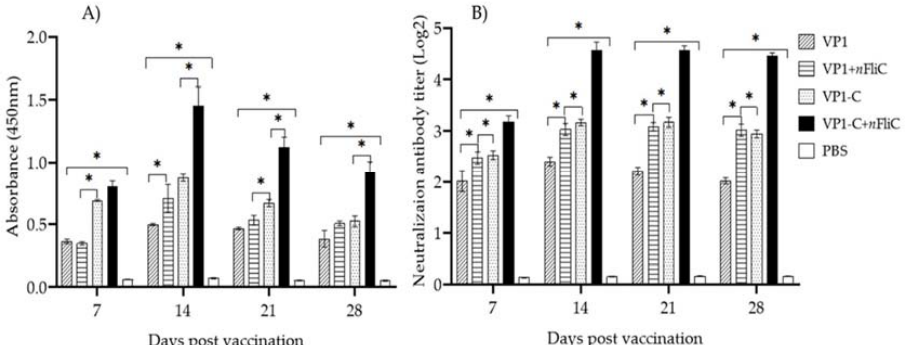
Figure 2. Virus-specific antibody levels of vaccinated ducklings. Ducklings ( n = 3 per group) were vaccinated once with five different vaccine formulations: (1) VP1, (2) VP1 + n FliC, (3) VP1-C, (4) VP1-C + n FliC, and (5) PBS, and virus-specific antibody levels were determined by indirect ELISA. ( A ) IgG antibody level of vaccinated ducklings; ( B ) Neutralization antibody titer of vaccinated ducklings. Data are presented as mean ± SD. An asterisk indicates statistically significant difference ( p < 0.05).